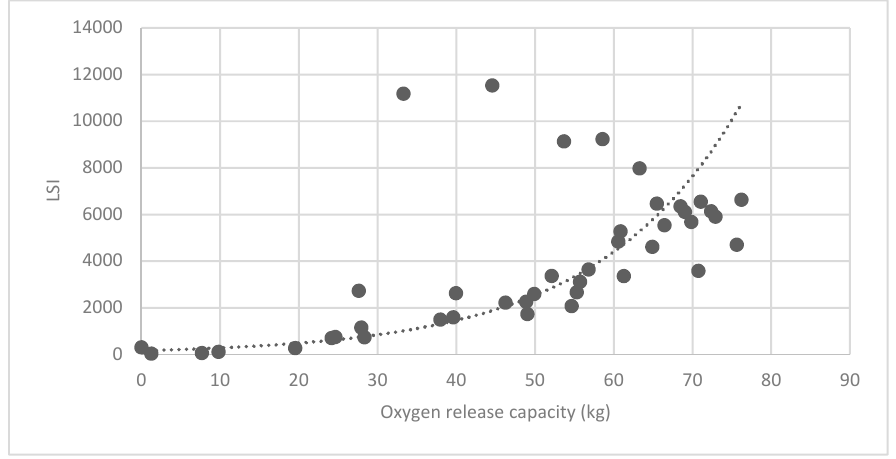
Figure 25. Association between the landscape shape index (LSI) of brush, and carbon fixation capacity.